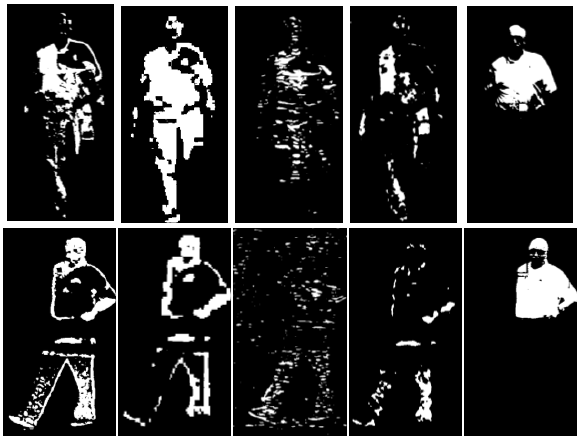
Figure 8. Detailed detected object in indoor and outdoor